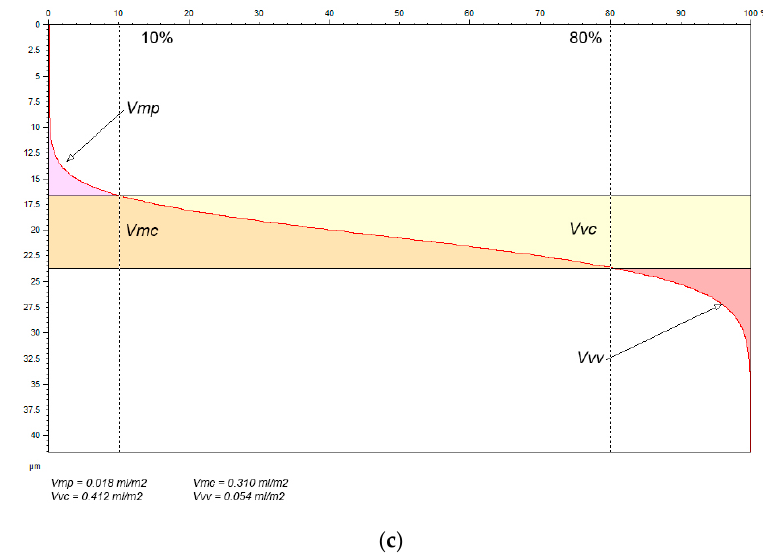
Figure 2. Parameters from the Sk ( a ), Sq ( b ), and V ( c ) groups.